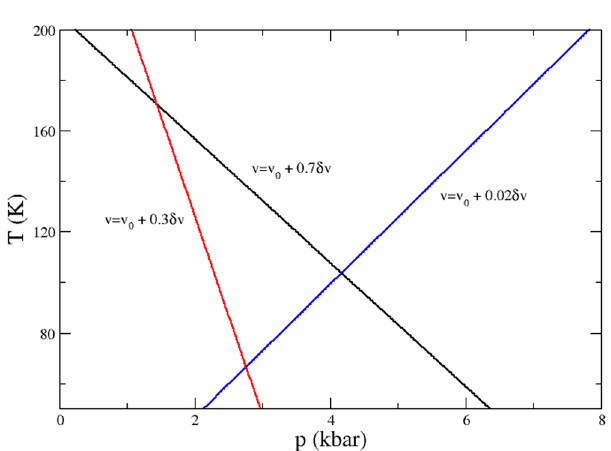
Figure 3. ( a ) Isobaric thermal expansivity α p , ( b ) isobaric heat capacity c p , ( c ) Grüneisen parameter α Γ = c / 2 , ( e ) speed of sound w normalized by its value on the critical point, ( d ) Grüneisen parameter α Γ = w c / w p p 1 , ( f ) isothermal compressibility κ namely ≈ . − w 6 513 m s for different values of pressure. The employed c T parameters were the same as presented in the caption of Fig. 2. The critical temperature is indicated by the vertical blue solid lines. Further details are discussed in the main text.